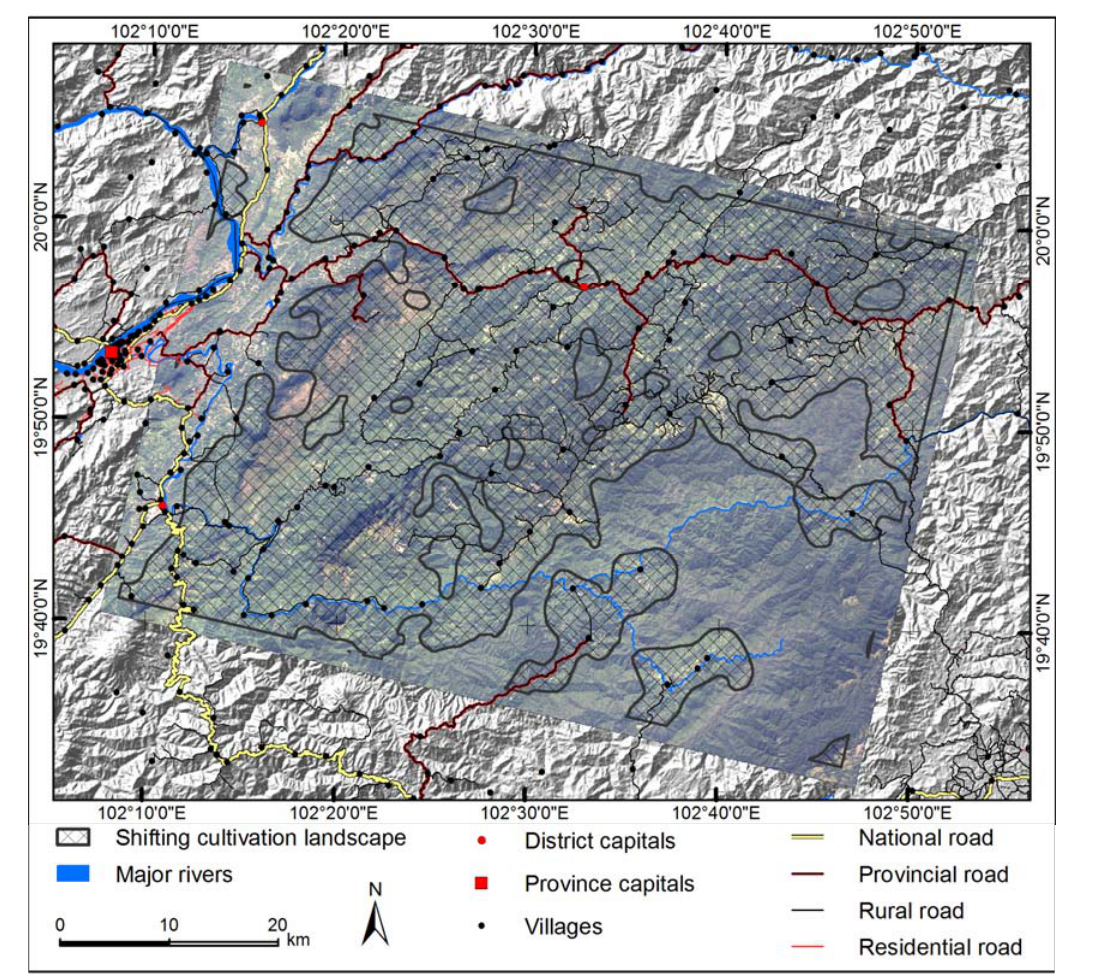
Figure 5. Shifting cultivation in the east of Luang Prabang: comparison of the delineation of the area where shifting cultivation prevails with a pan sharpened ALOS AVNIR